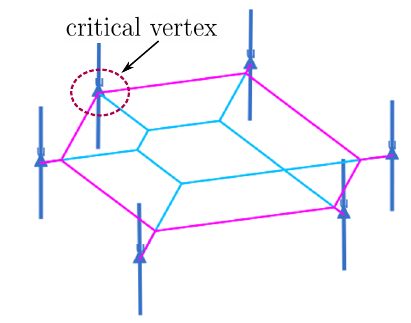
Figure 22 . Here we illustrate examples of webs containing a loop with six vertices. Such webs come in a continuous family bounded by two limiting configurations. One limit is a web containing a loop with six vertices where one vertex is directly attached to a link strand; this limit is shown in pink. The other limit is a tree with a self-intersection; this limit is shown in light blue. The vertex of the limiting web that is directly attached to a link strand is called the critical vertex